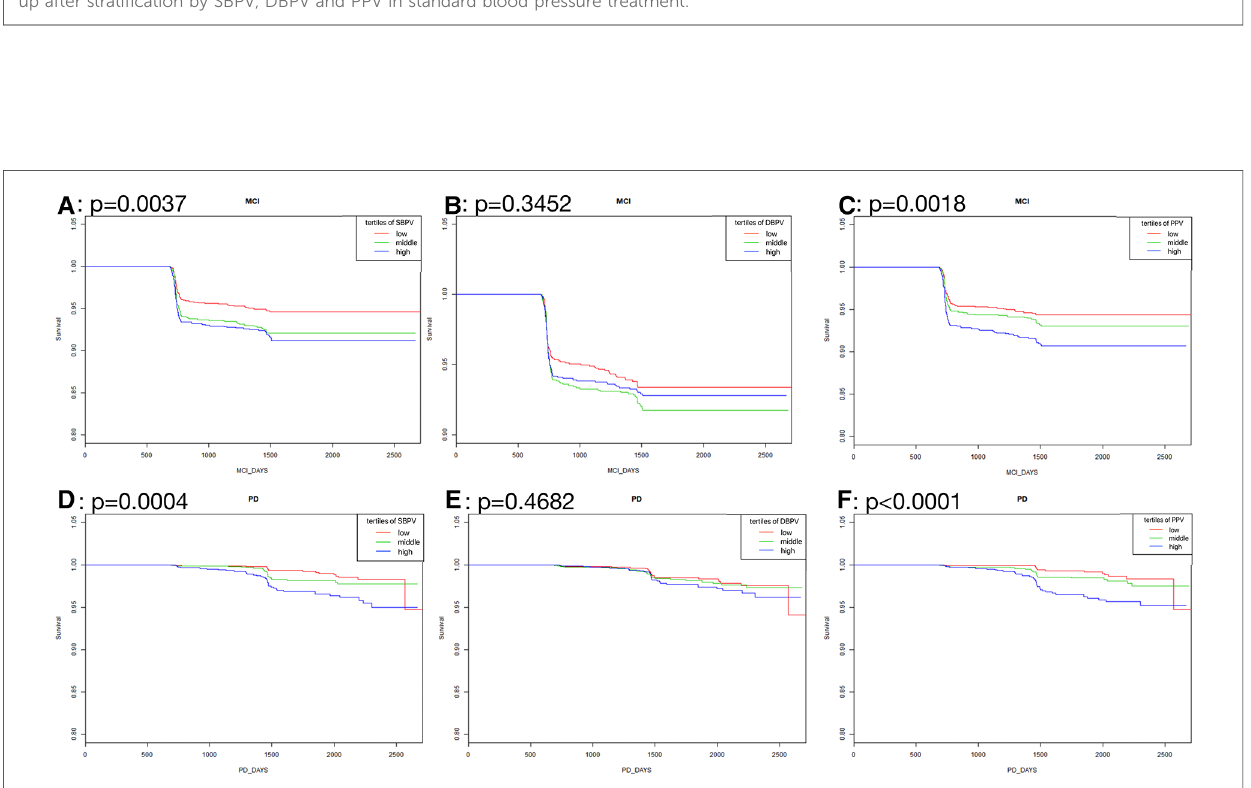
FIGURE 3 Kaplan-Meier curves analysis among tertiles of BPV in intensive blood pressure treatment. ( A – C ) Showed the rates free of mild cognitive impairment in follow-up after strati fi cation by SBPV, DBPV and PPV in intensive blood pressure treatment; ( D – F ) showed the rates free of probable dementia in follow-up after strati fi cation by SBPV, DBPV and PPV in intensive blood pressure